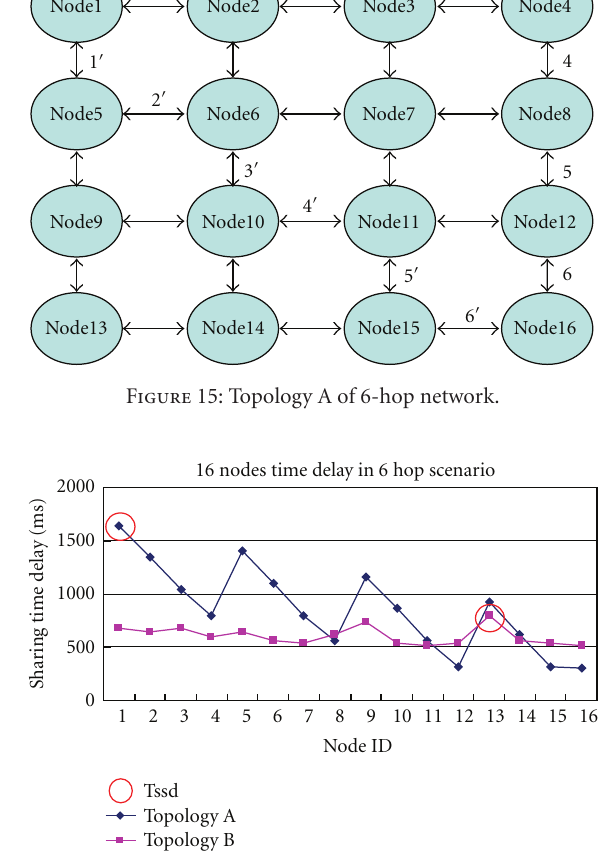
Figure 16: Sharing time delay in 6-hop